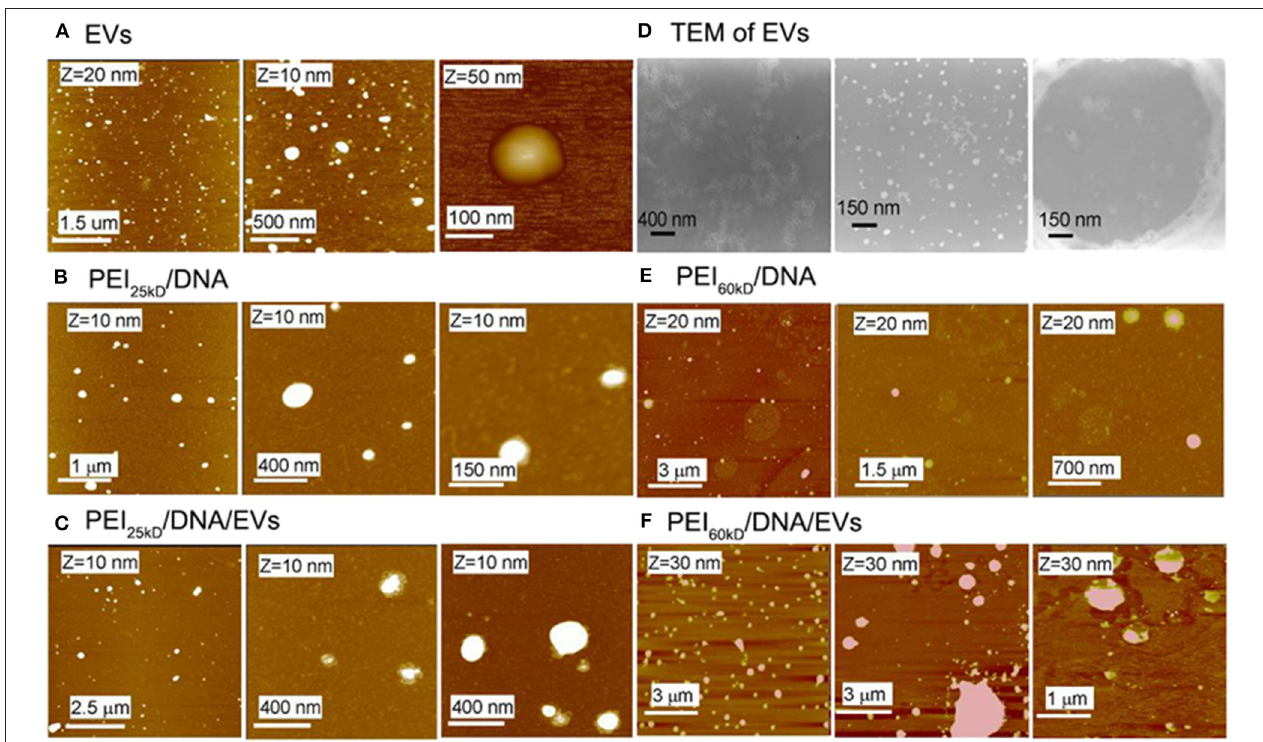
FIGURE 2 | AFM images of (A) EVs, (B) PEI 25kD /DNA, (C) PEI 25kD /DNA/EVs, (E) PEI 60kD /DNA, (F) PEI 60kD /DNA/EVs, and (D) TEM images of EVs. In (A) , the EVs were adsorbed on positively charged mica that was functionalized with (3-amino- propyl)triethoxysilane. In (B,C,E,F) , the complexes were adsorbed on freshly cleaved mica. In (D) , the left image shows EVs that were fixed with PFA, stained with PTA, and adsorbed on positively charged carbon grid; the middle image showed the EVs that were fixed with PFA, stained with PbAc, and adsorbed on positively charged carbon grid; the right image shows the EVs that were fixed with PFA, stained with PTA, and adsorbed on formvar grid.